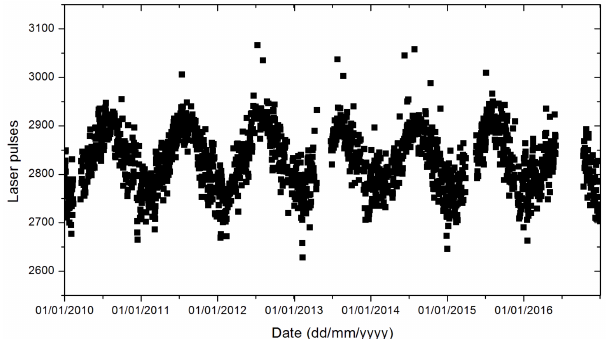
Figure 14. Number of laser pulses hourly emitted by the CHM15k as a function of the time for the measurement period from 2010 to